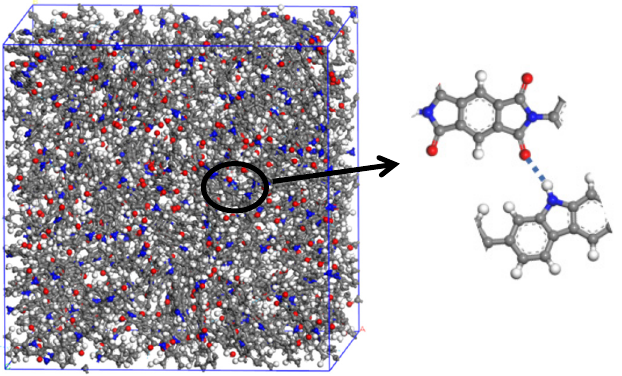
Figure 6. H-bonds between − HN − and O=C − in simulation cell of M-2,7-CPPI.